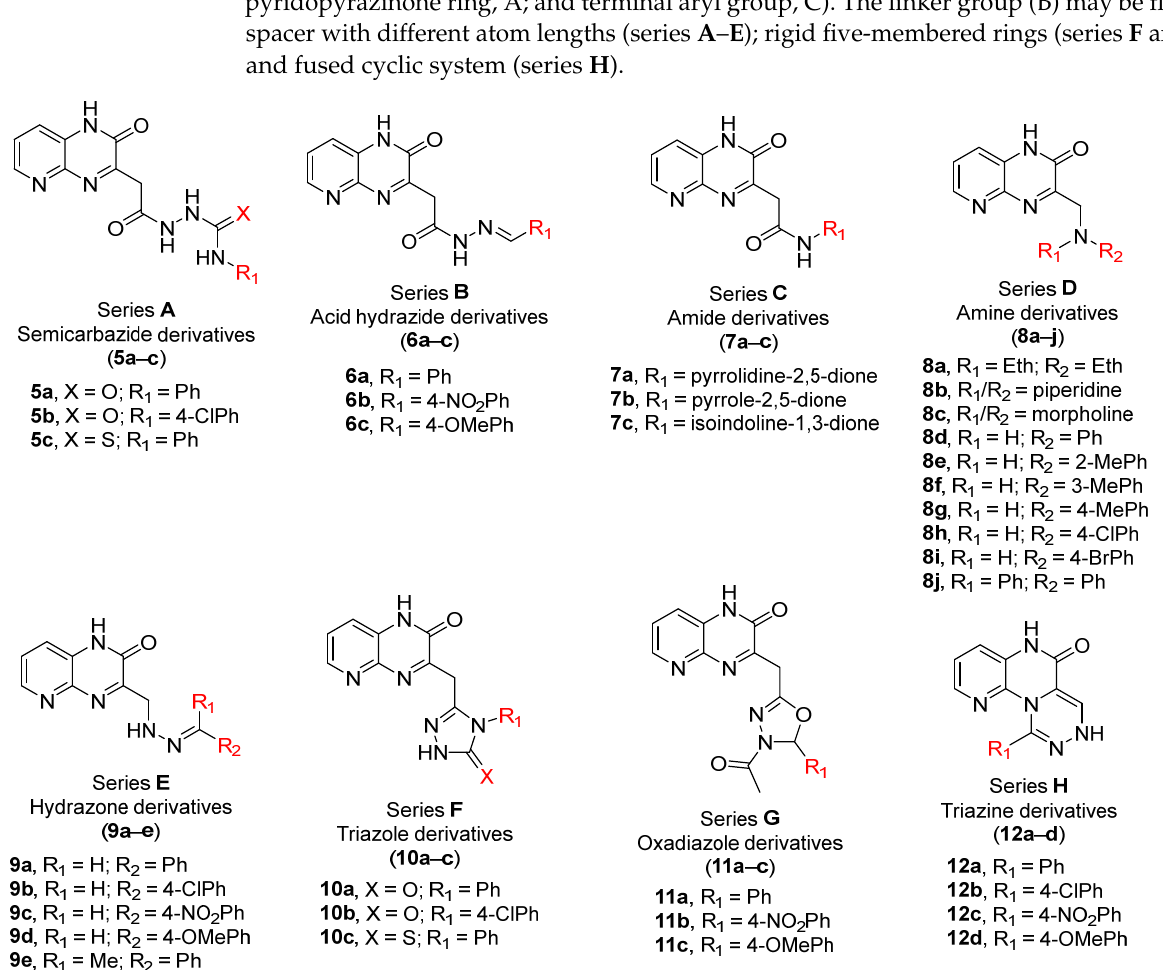
Figure 2. The tested pyridopyrazinone derivatives. Eight different series ( A – H ) with structural variation in the spacers between the core pyridopyrazinone scaffold and the terminal aryl motif. Series A – E with flexible spacer with different length as well as different incorporated HBD/HBA atoms. Series F and G with 5 ‐ membered rigid spacers (triazole and oxadiazole, respectively). Series H with rigid tricyclic system. (Table S2).